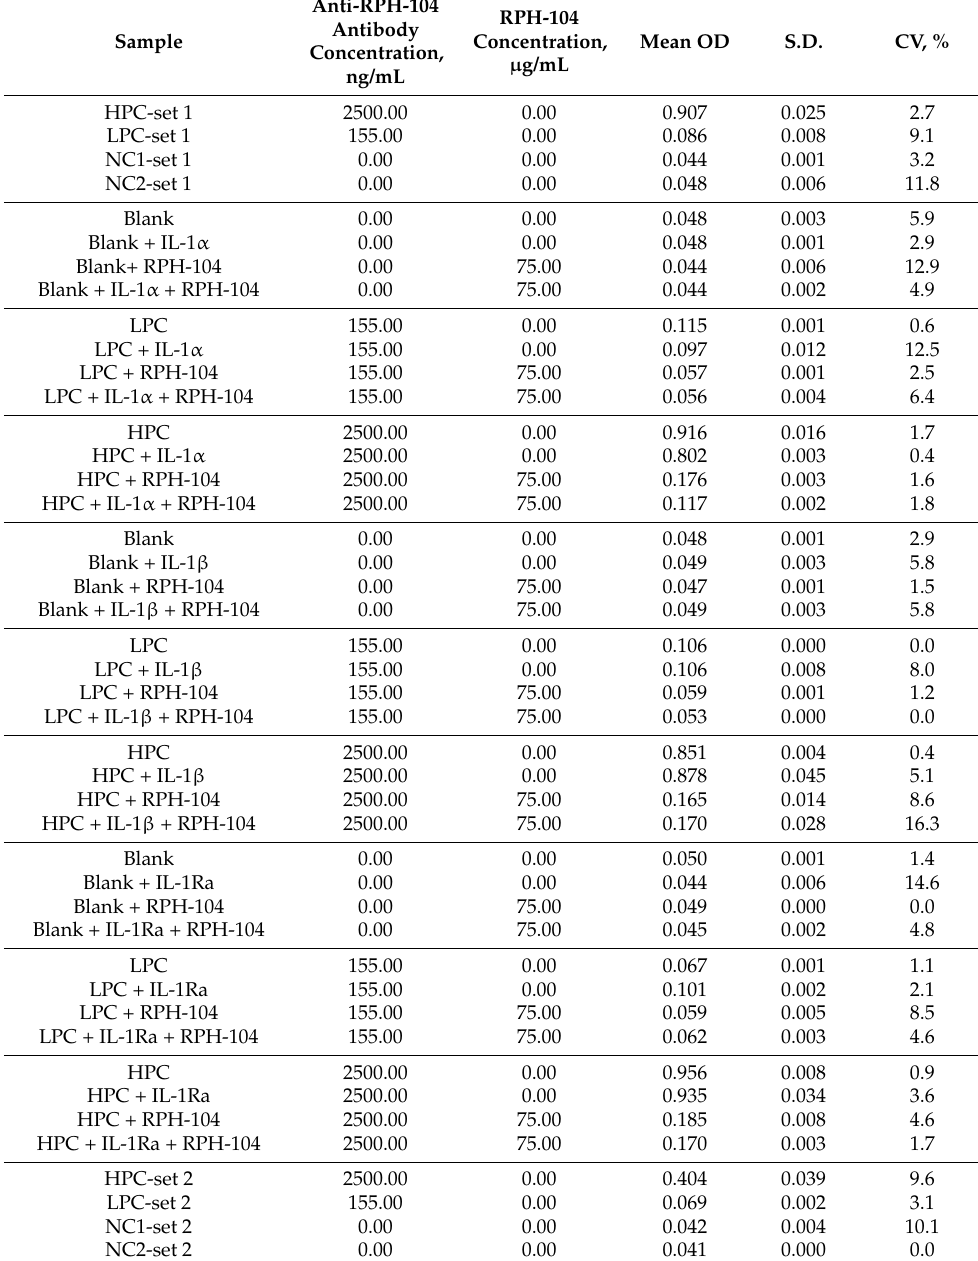
Table 8. Results of the method specificity